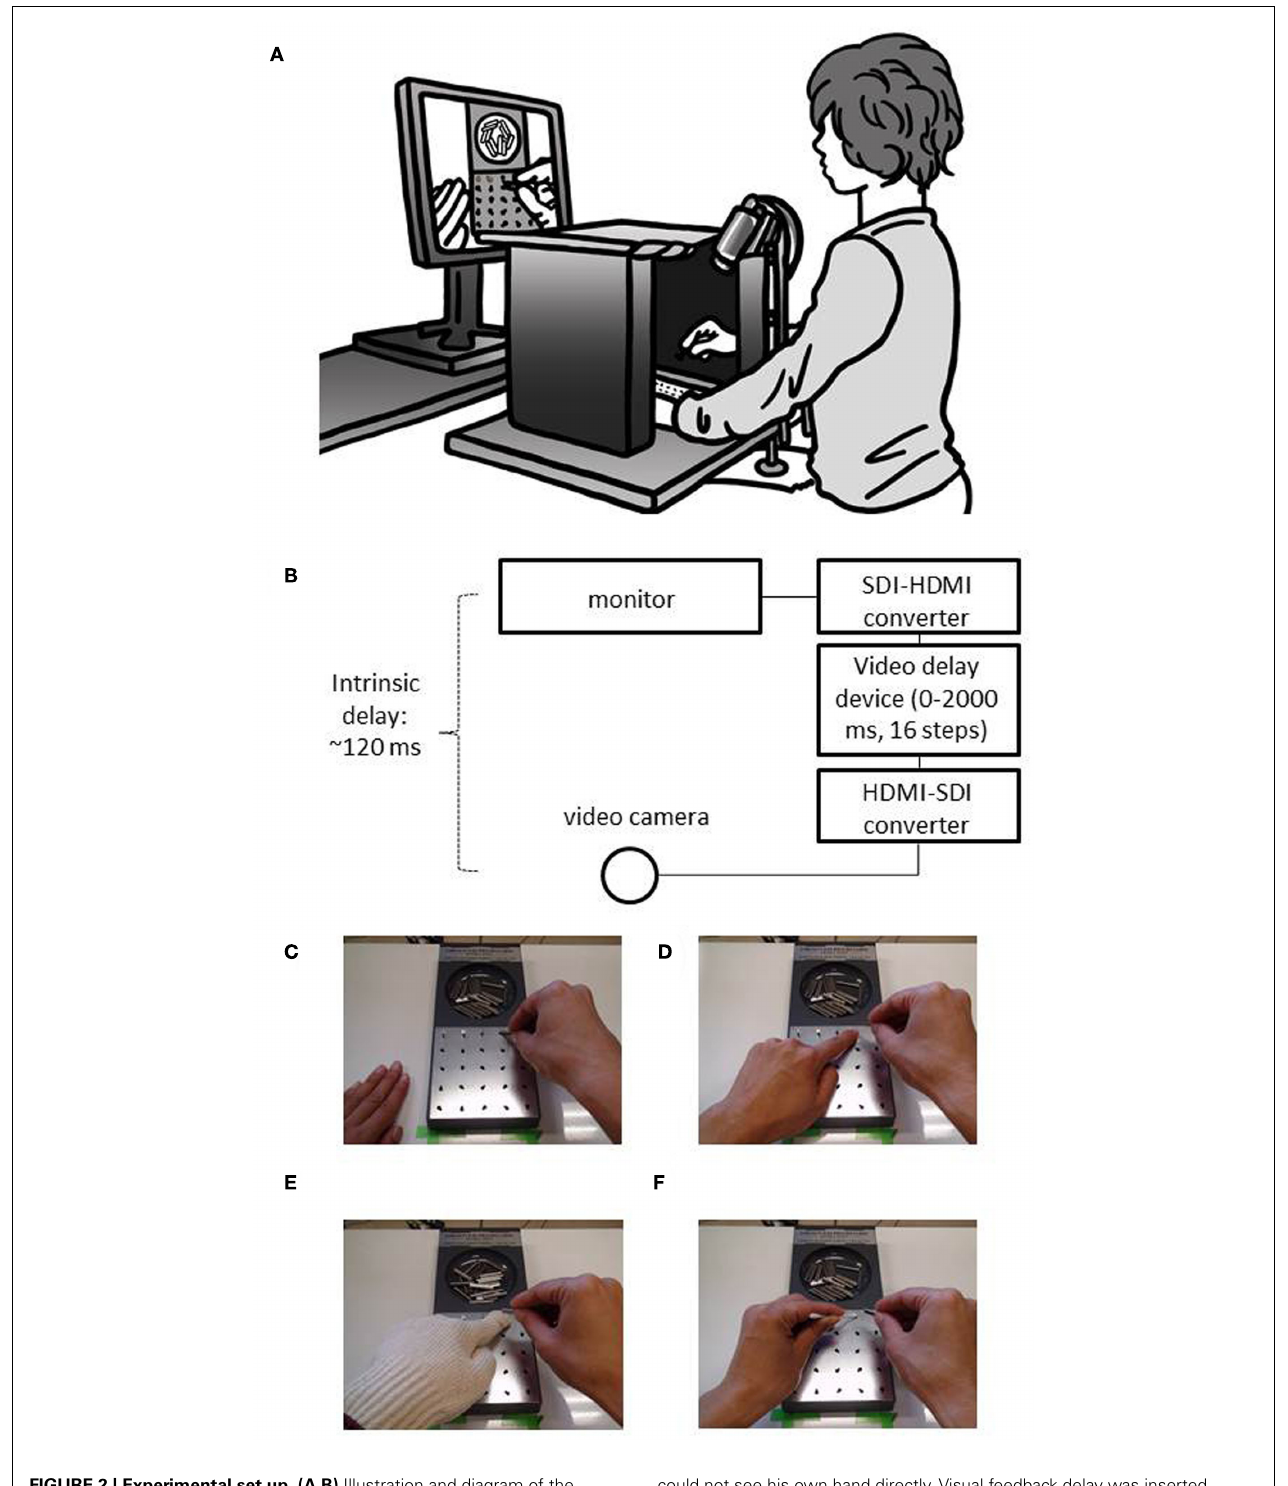
FIGURE 2 | Experimental set up. (A,B) Illustration and diagram of the experimental set up.The participant sits at a table and puts both his hands on the table.The pegboard is placed in front of the participant. Both the participant’s hands and the pegboard apparatus were occluded by a black-cloth-covered cardboard, so that the participant